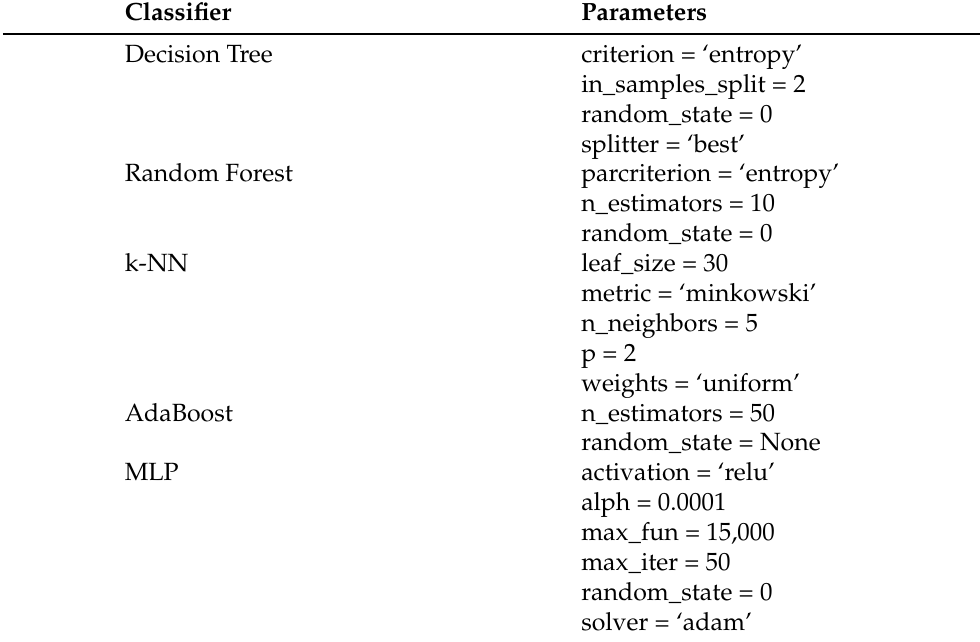
Table 5. Parameters used for comparison of decision tree, random forest, k-NN, AdaBoost, and MLP.